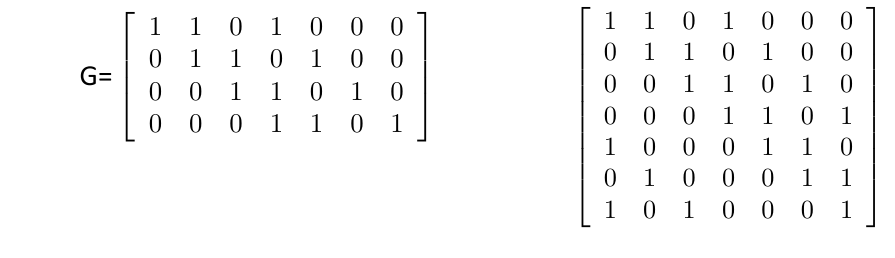
Figure 5 . Cyclic Hamming code. The generating matrix G at the left part has 4 rows with 3 1’s each, where every row is a cyclic permutation of the previous one. More cyclic permutations generate directly the 7 codewords at the right of the figure, all with 3 1’s, 4